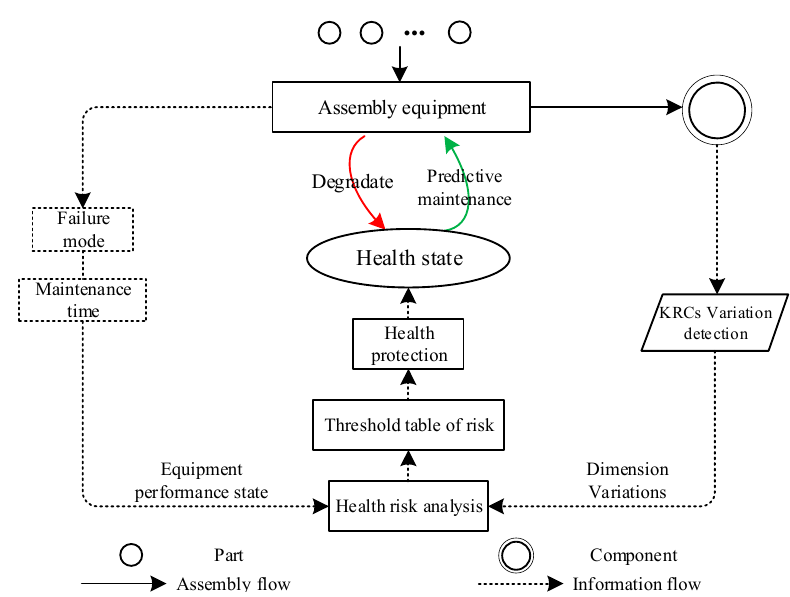
Figure 4. Schematic of the predictive maintenance mechanism of the equipment layer.